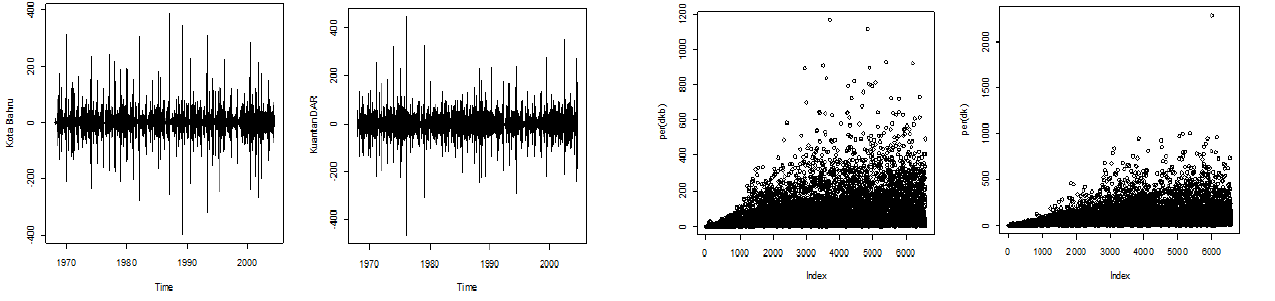
Fig. 5. Periodogram of the first difference series of Kota Bharu and Kuantan. Table 2a. Summary statistics for the rainfall data